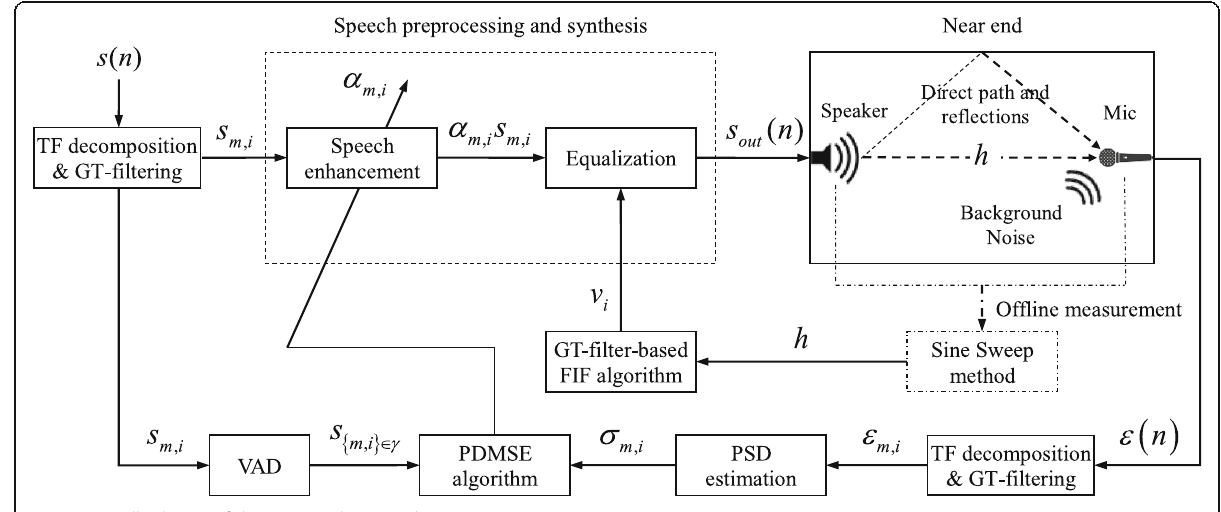
Fig. 1 Overall scheme of the proposed